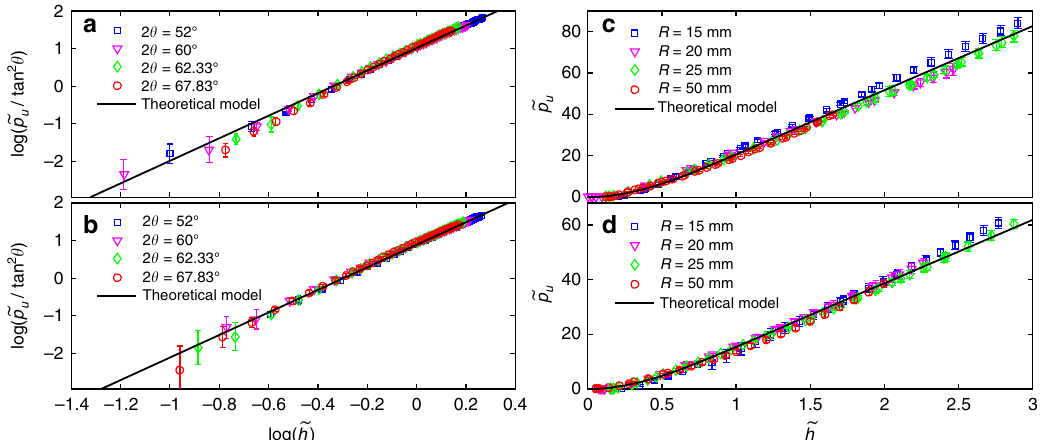
(cid:3) (cid:4) vs. log ~ h , measured from the intruder ’ s bottom, for conical intruders of different Fig. 7 Intrusion of cones and spheres. a , b The rescaled force log ~ p u = tan 2 θ head angles 2 θ penetrating glass beads 2 and 3. We normalise depth by R = 20 mm to coincide with our cylindrical intruders experiments. The experimental data are in good agreement with the theoretical calculation (solid lines), ~ p u ¼ tan 2 θ K ϕ ~ h 3 = 3. c , d The same as in a , b for spherical intruders of different radii, penetrating glass beads 2 and 3. Again, the experimental data agree well with the theoretical curves (solid lines): ~ p u ¼ K ϕ ~ h 2 ð 1 (cid:2) ~ h = 3 Þ and ~ p u ¼ K ϕ ð ~ h (cid:2) 1 = 3 Þ for ~ h (cid:3) 1 and ~ h > 1, respectively. All the measurements were taken on three samples for each of the four experiments, with the error bars representing the standard deviation over the samples. The fi ts qualities are: R 2 >0.991, 0.993, 0.993 and 0.995, respectively, for a –